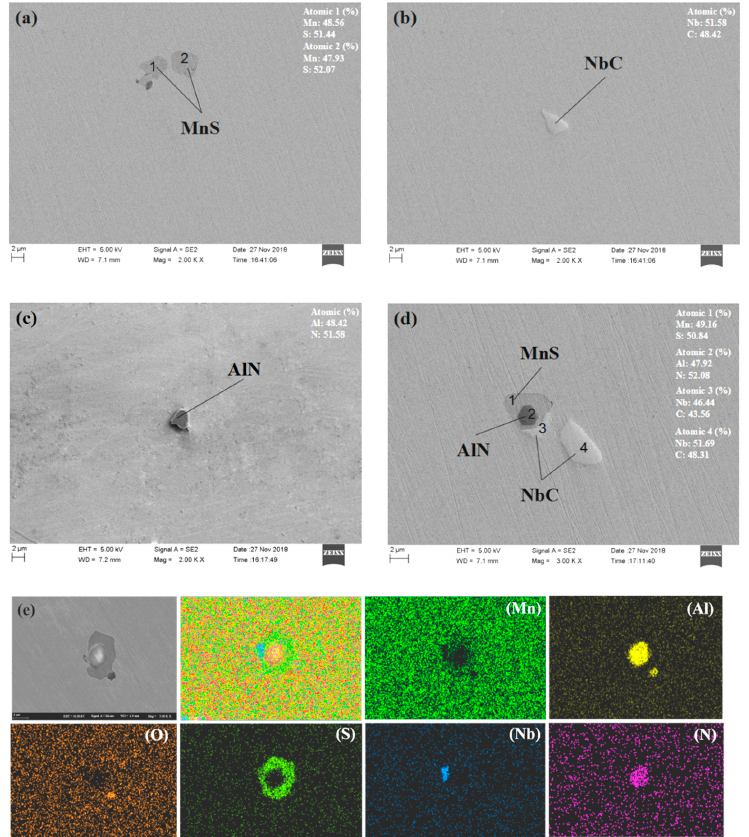
Figure 4. Morphology of typical inclusions in TWIP steel (steel C) (the mass fraction of Al and Nb is 1.5% and 0.04%, respectively). ( a ) MnS inclusion; ( b ) NbC inclusion; ( c ) AlN inclusion; ( d ) AlN-MnS-NbC complex inclusion; ( e ) the surface scan of niobium complex inclusion.